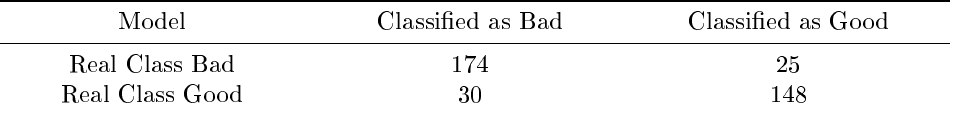
Table 4: J48 Results (tested in subset A)